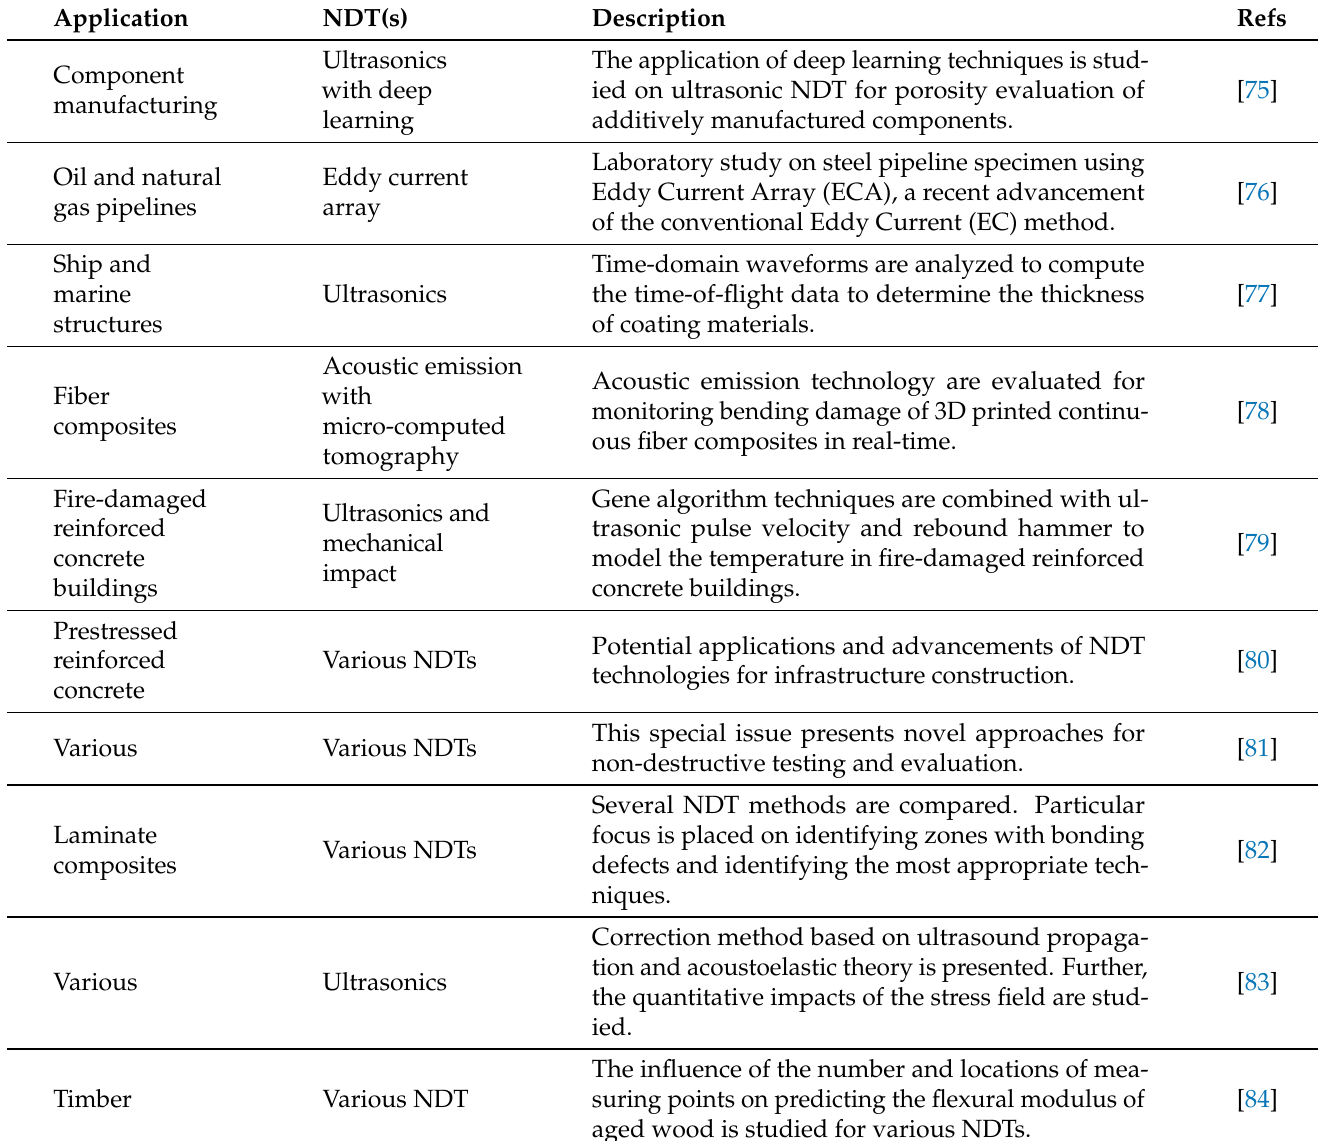
Table 5. Recent NDT studies and their